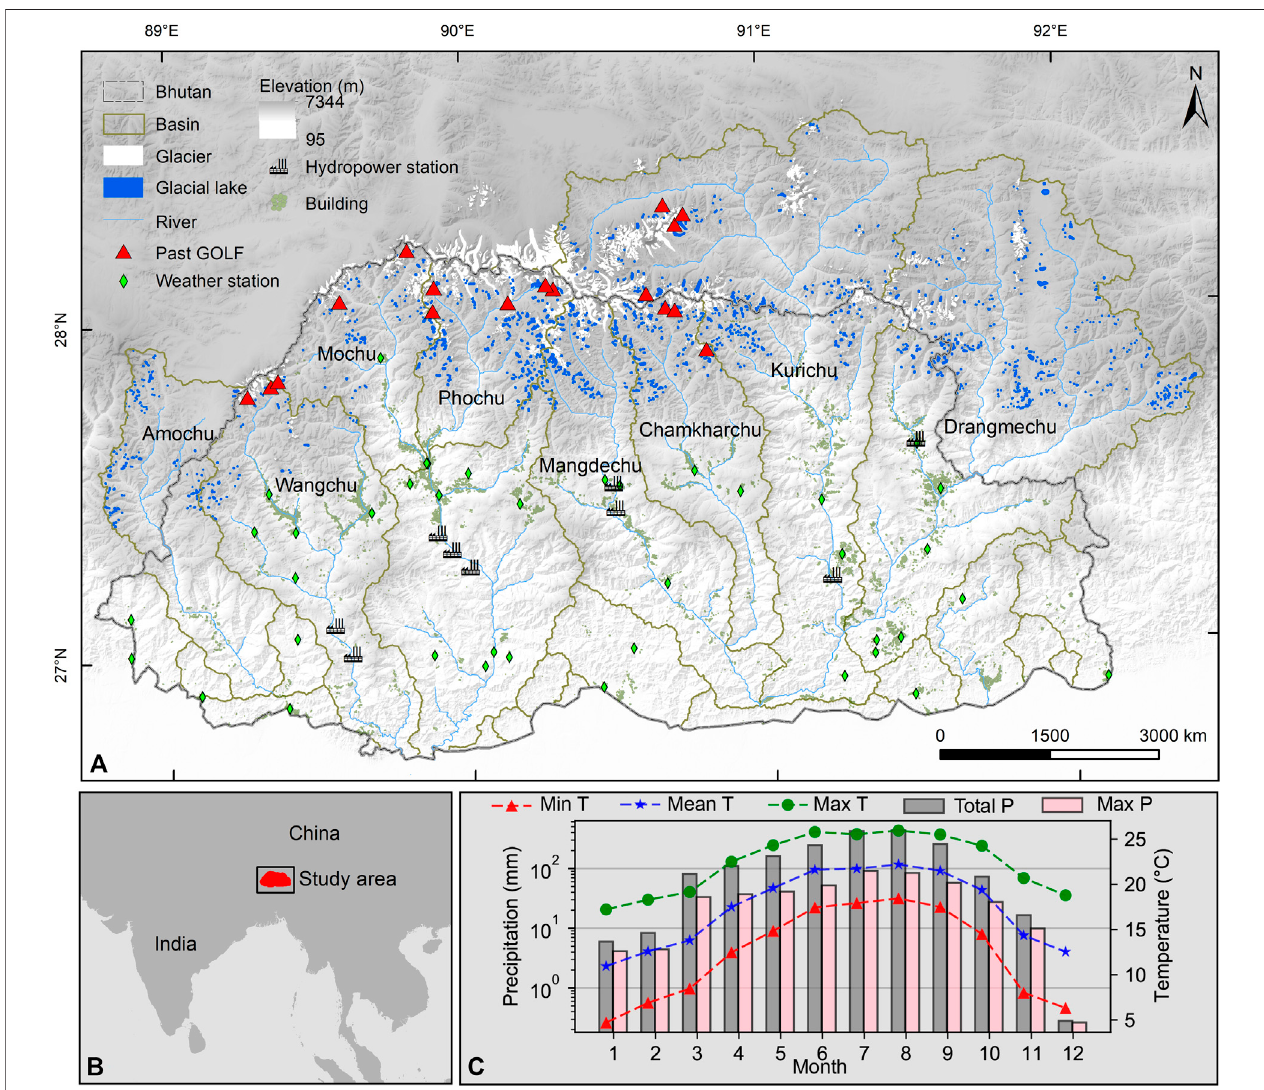
FIGURE 1 | The setting of the Bhutan Himalaya. The map (A) shows the distribution of glaciers (Nagai et al., 2016), glacial lakes (Wang et al., 2020), historical GLOFs(Komori etal.,2012),hydropower stations, andbuilt-up areas intheeight basins.Thebasemap indicates theelevation changeasper SRTM-30 m.Themap (B) depicts the location of the Bhutan Himalaya. The line and bar charts (C) represent the monthly temperature (T) and precipitation (P) in 2017 as per the latest records maintainedbyNCHM(2018)derivedfrom42weatherstationsacrossthecountry.BasinboundariesandrivernetworksweredelineatedfromSRTM-30musingthe hydrology toolset. The administrative boundary of Bhutan was downloaded from https://data.humdata.org/dataset/bhutan-administrative-boundaries-levels-0-2. It should be noted that the study area extends into Tibetan Autonomous Region (TAR), China and Arunachal Pradesh, India on the eastern side, and TAR on the western side due to transboundary glacial-fed rivers that fl ow into inland